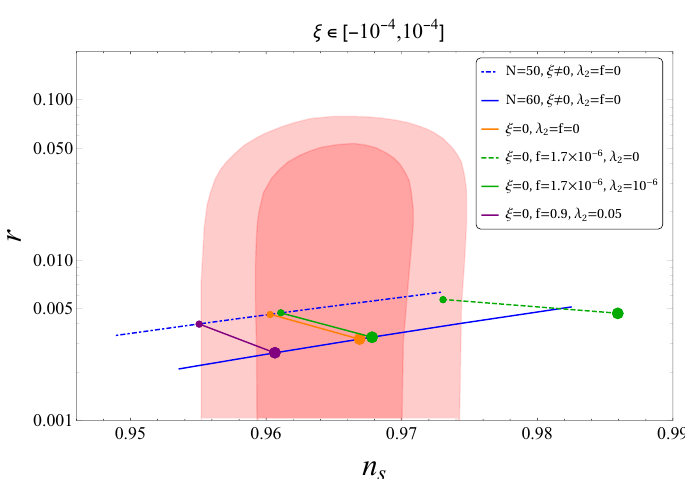
Figure 5 . A logarithmic plot for the model predictions in the n s − r plane. We have fixed A ∼ 10 − 10 . The solid (dash-dotted) blue curves correspond to N = 60 ( N = 50 ) respectively where we scanned over B = 1 + ξ with ξ ∈ [ − 10 − 4 , 10 − 4 ] , with f = λ = 0 . The other segments correspond to fixed 2 B = 1 ( ξ = 0) with different values of f, λ 2 and we have scanned over N = 50 − 60 (small-big) dots, for each segment. The dark and light red regions correspond to the 1 and 2 sigma exclusion limits released by the Planck collaboration (2018) (TT+ TE+ EE + LowE + Lensing + BK14)